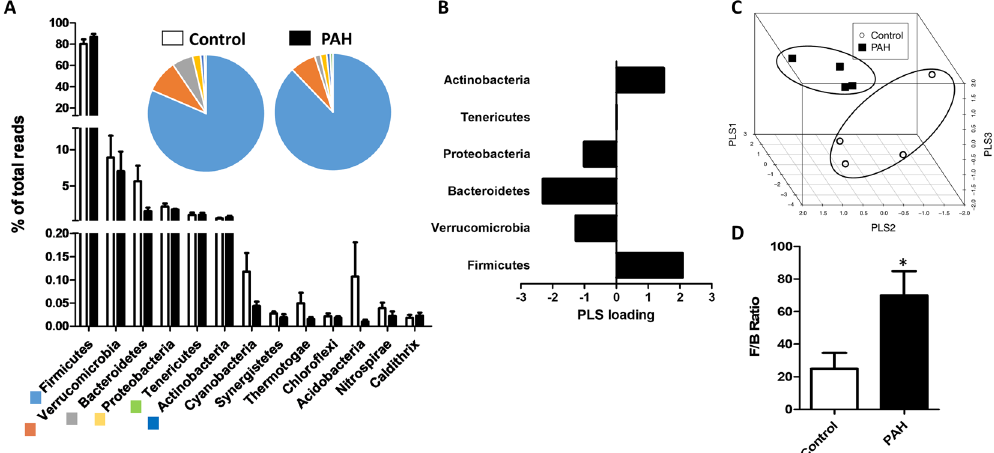
Figure 3. Phyla composition. ( A ) Composition of the most abundant bacterial phyla ( > 0.01%) expressed as a percent of total bacteria (means ± s.e.m. of 4 animals). The inset shows the pie charts for control and PAH. ( B ) PLS loadings (data shown for phyla representing > 0.1% of total bacteria) highlight variable significance to discriminate between PAH and control samples in PLS scores. ( C ) Tridimensional PLS scores plot. ( D ) The Firmicutes to Bacteroidetes ratio (F/B ratio) was calculated as a biomarker of gut dysbiosis (means ± s.e.m., n = 4, * p = 0.04 vs control with student’s t-test).